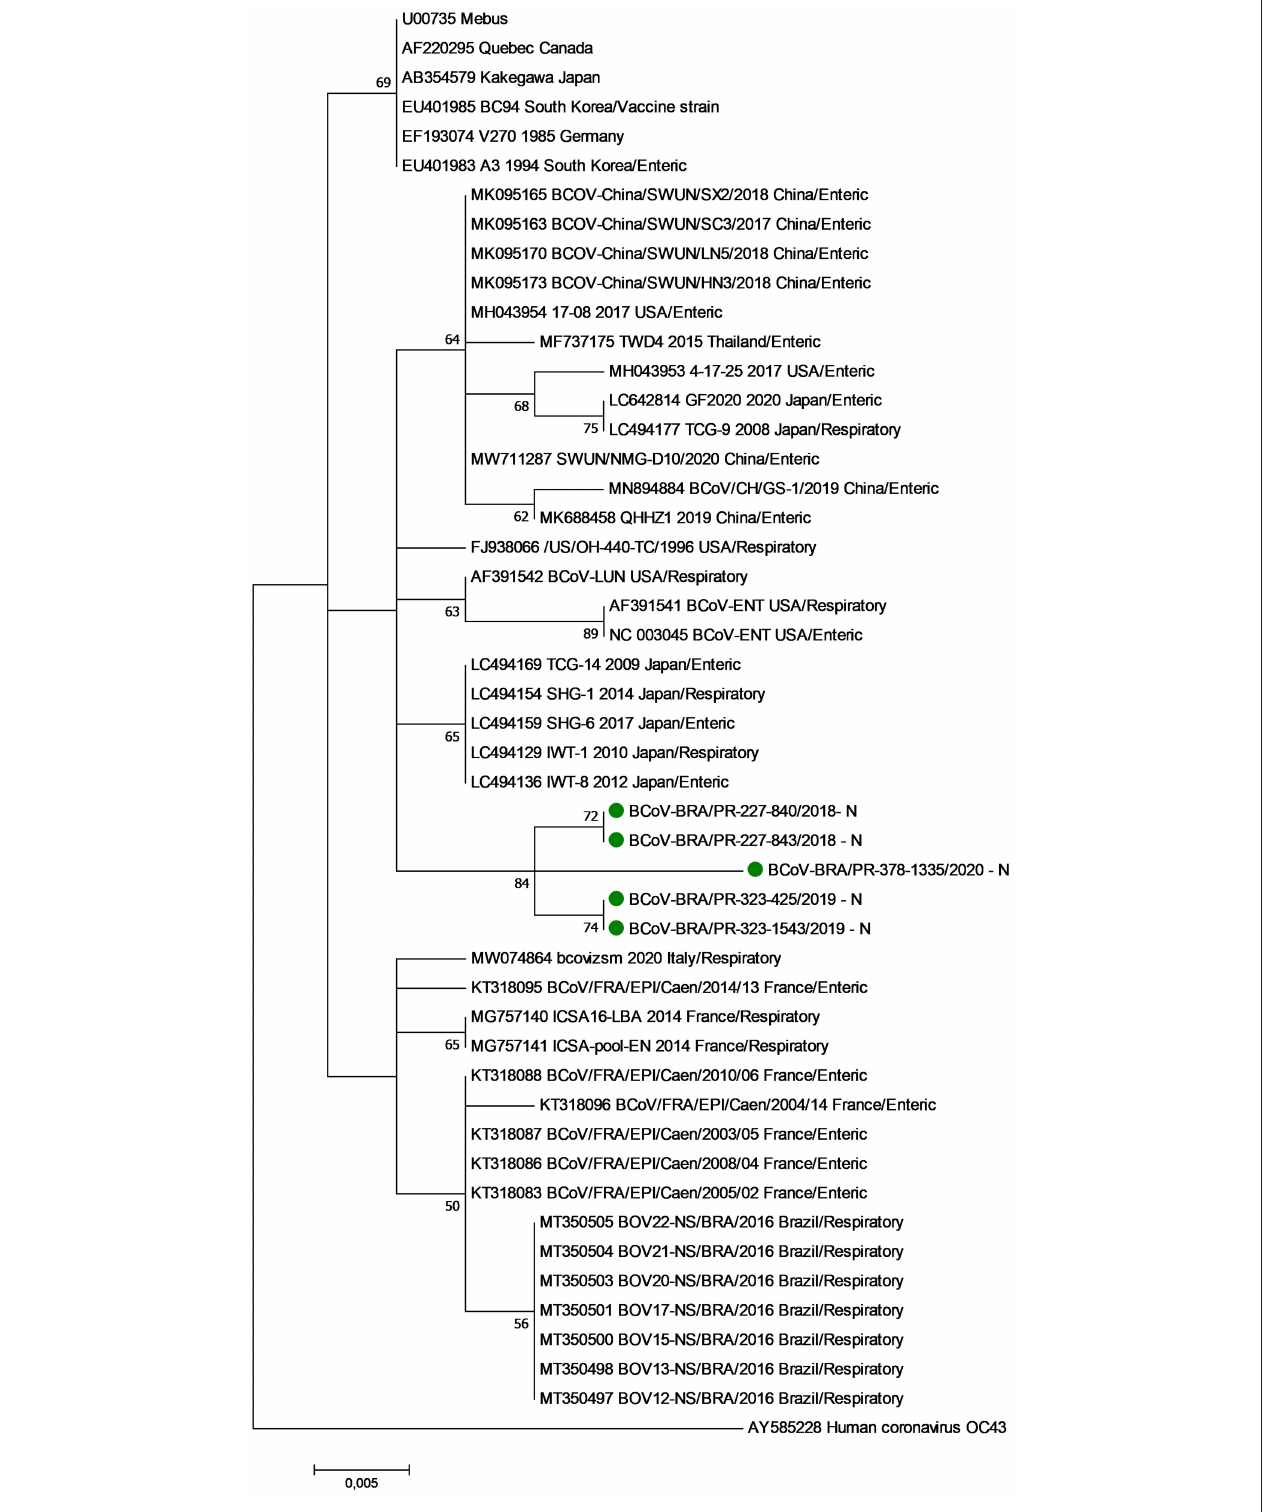
FIGURE 1 | Phylogenetic analysis by the maximum likelihood method of partial (285 nt) N gene of bovine coronavirus strains. The evolutionary history was inferred by using the maximum likelihood method based on the general time reversible model. The percentage of trees in which the associated taxa clustered together is shown next to the branches. The tree is drawn to scale, with branch lengths measured in the number of substitutions per site. The analysis involved 48 nucleotide sequences of bovine coronavirus. A human coronavirus OC43 sequence was used as an outgroup. Evolutionary analyses were conducted in MEGA7. The BCoV strains identified in this study are marked with green filled